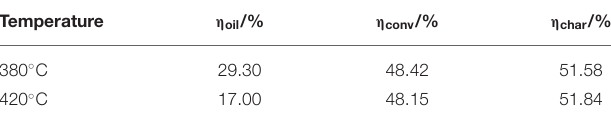
TABLE 8 | Constituents of gas obtained by tetralin and high-pressure hydrogen